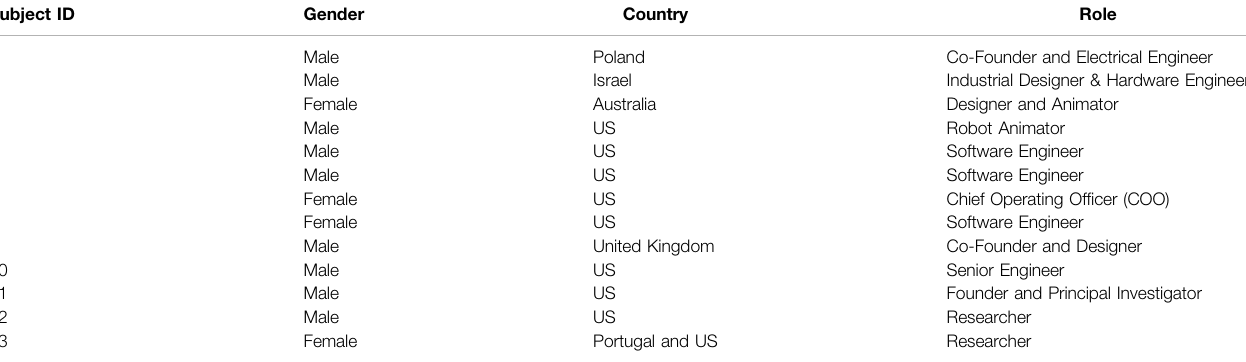
TABLE 1 | Demographic description of study subjects. All subjects are robot creators who designed and built one or more robots in a research lab or